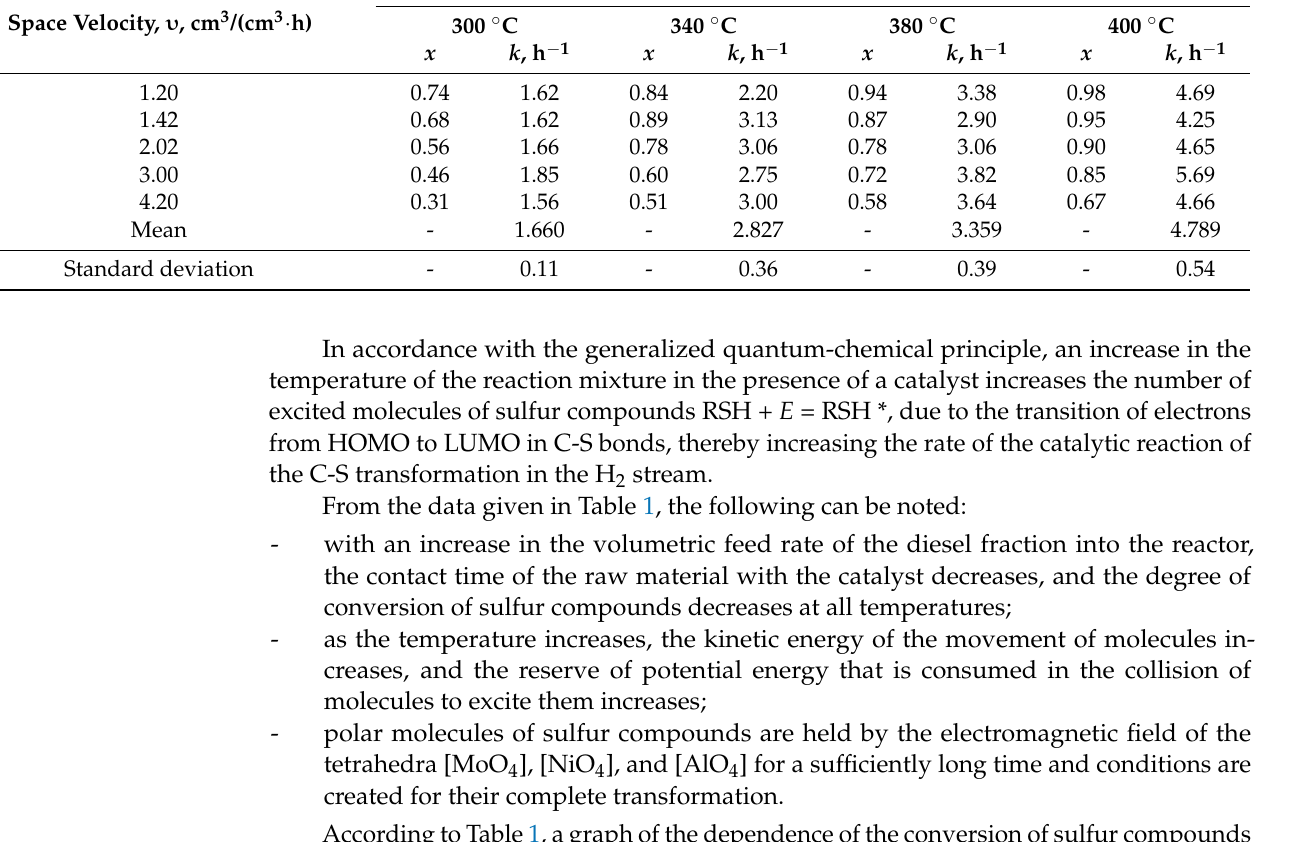
Space Velocity, υ , cm 3 /(cm 3 ·